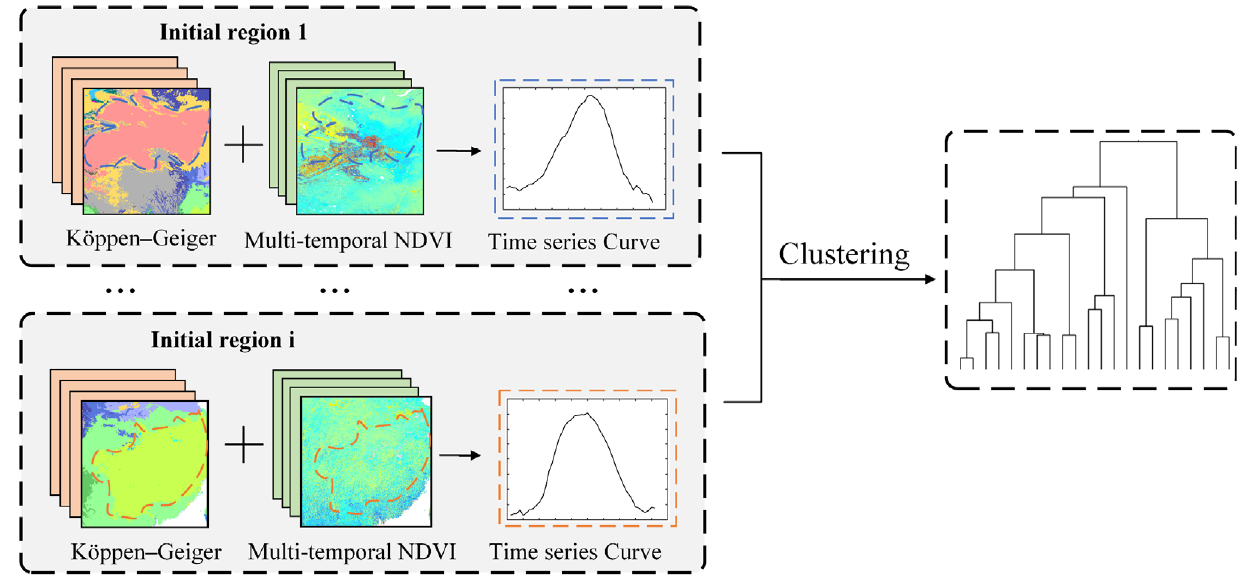
Figure 3. The process of the regional division method.